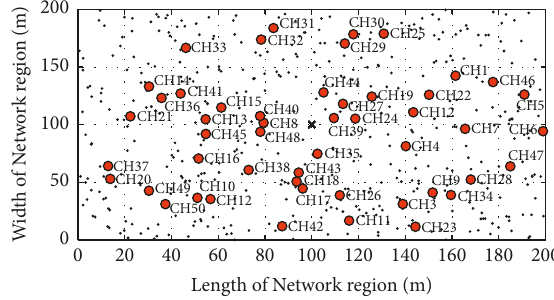
Figure 8: Random deployment of a wireless sensor network with 500 nodes and 50 CHS selected by MRFO algorithm.